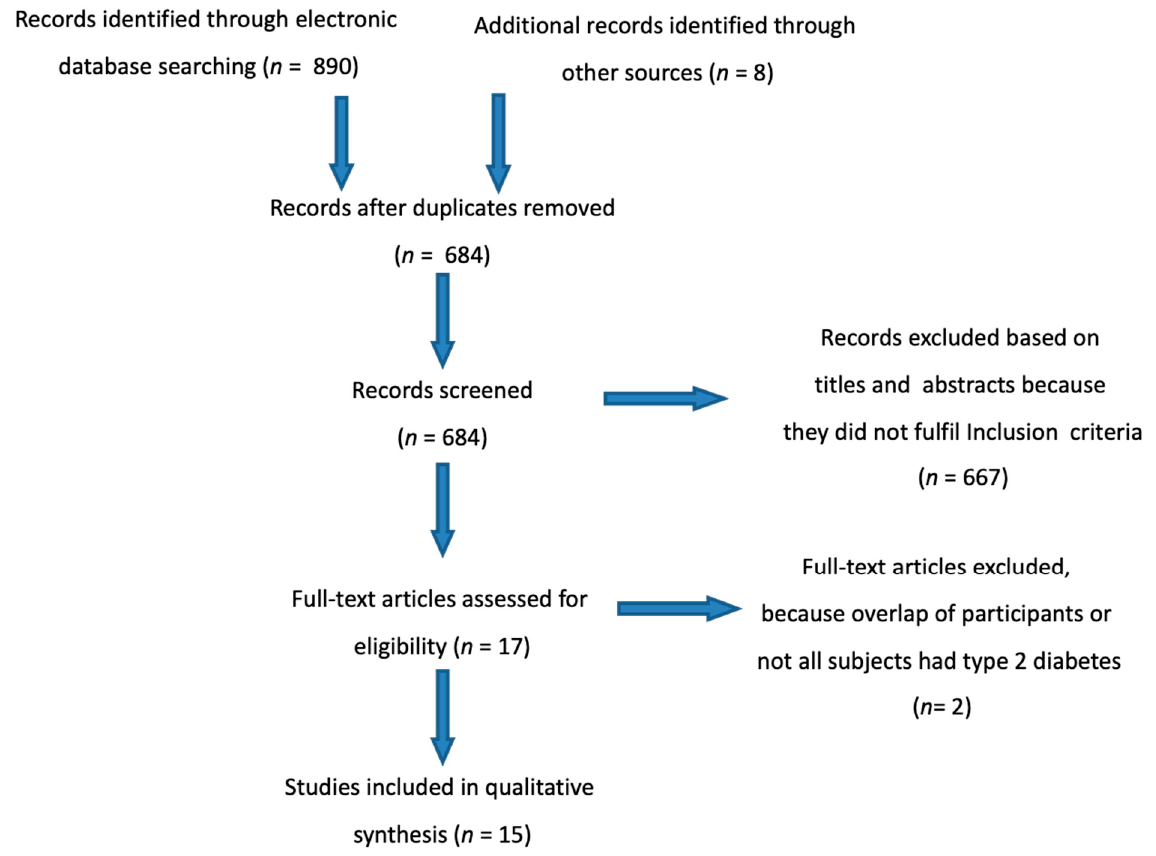
Figure 1. Flow diagram of study selection.